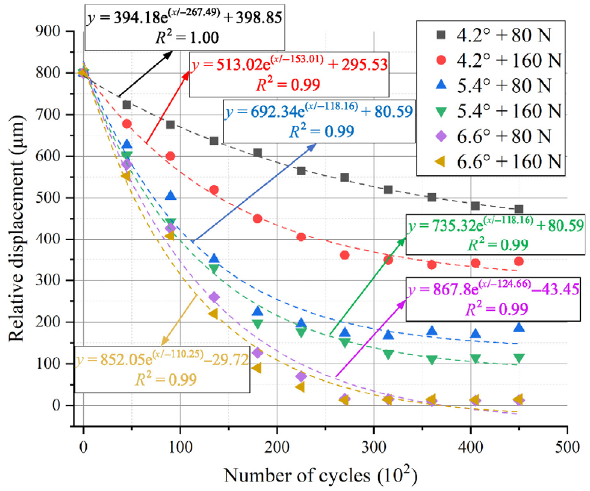
Fig. 13 Evolution trends of relative slip under dry friction.